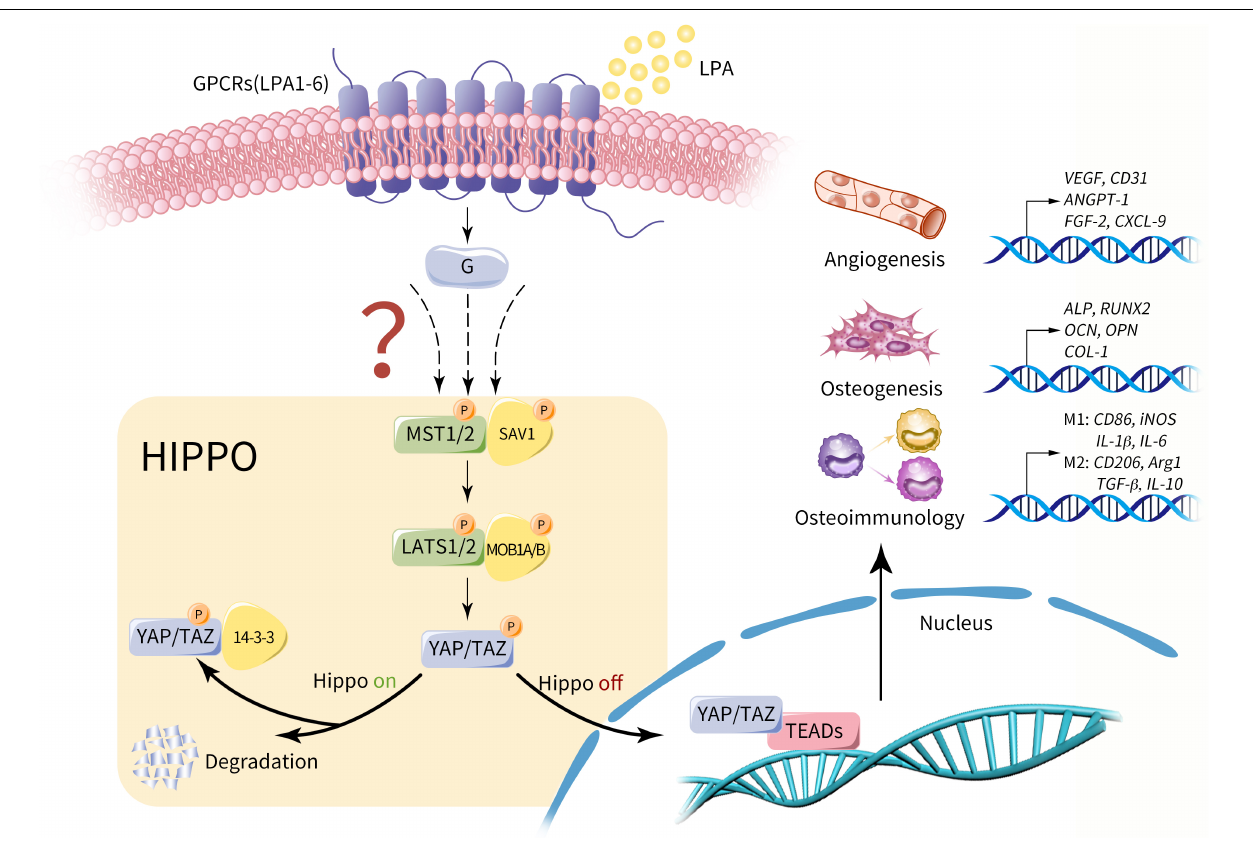
FIGURE 3 | Potential role of LPA on Hippo-YAP mediated osteogenesis, angiogenesis and osteoimmunology. LPA may act as an upstream extracellular signal of Hippo pathway via GPCRs (LPA1-6). Provided that Hippo pathway is activated, MST1/2 and SAV1 are phosphorylated and activate the complex of LATS1/2 and MOB1A/B. As a result, the phosphorylated YAP/TAZ is sequestrated in the cytoplasm by interacting with 14-3-3 proteins or degraded. Conversely, in the context of Hippo off, YAP/TAZ is dephosphorylated and translocate into nucleus, regulating a variety of cell properties by influencing gene expression with its main transcriptional factor TEAD, including genes that dominate osteogenesis, angiogenesis and osteoimmunology. Therefore, we propose that LPA-Hippo axis may perform regulatory effects on osseointegration procedure by influencing osteogenesis, angiogenesis and